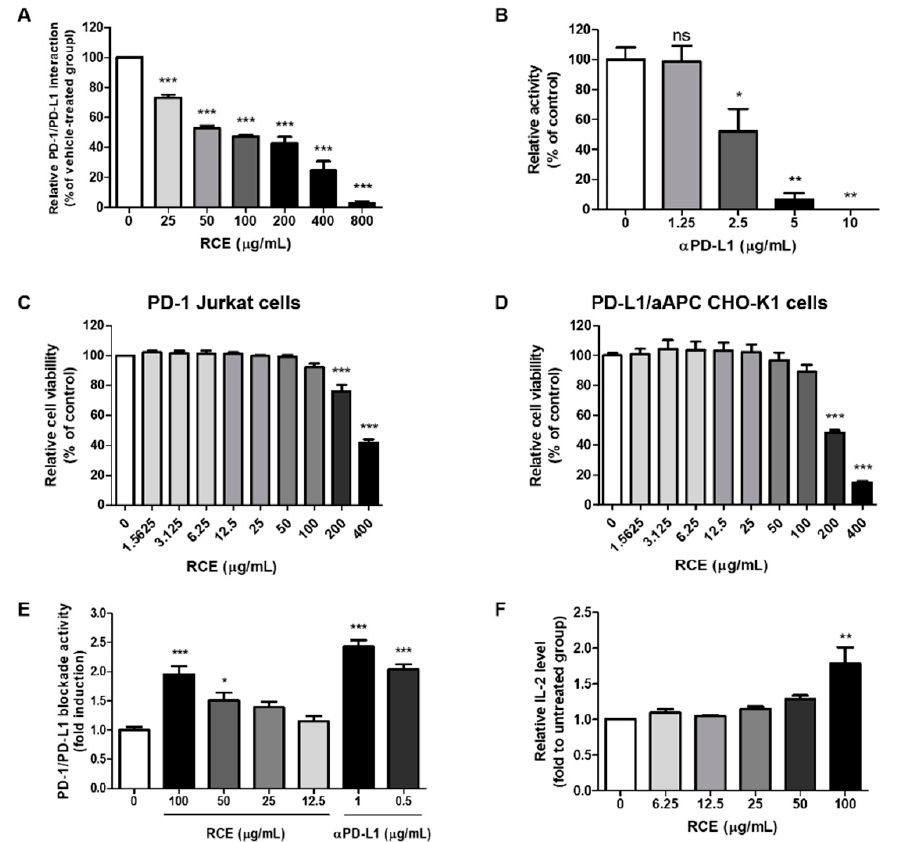
Figure 1. E ff ect of Rubus coreanus extract (RCE) on programmed cell death protein 1 (PD-1) / PD-1 ligand-1 (PD-L1) protein interaction using competitive enzyme-linked immunosorbent assay (ELISA) or cell-based assay. ( A , B ) The e ff ect of RCE on the binding of PD-1 and PD-L1 in vitro using a competitive ELISA assay. ( C , D ) The e ff ect of RCE on cell viability of PD-1 / NFAT Jurkat cells ( C ) and PD-L1 / aAPC CHO-K1 cells ( E ) using the Cell Counting Kit-8 (CCK) assay. Each of the cells were treated according to the indicated concentrations of RCE for 24 h. ( E ) The e ff ect of RCE on cellular PD-1 / PD-L1 blockade activity. PD-1 / NFAT Jurkat e ff ector cells and PD-L1 / aAPC CHO-K1 target cells were co-cultured with RCE or α PD-L1 for 24 h at the indicated concentrations. The relative PD-1 / PD-L1 blockade activity were measured by PD-1 / NFAT luciferase reporter assay. ( F ) E ff ect of RCE on IL-2 cytokine release in co-cultured cell model. Cell culture media was analyzed to measure IL-2 level by cytokine ELISA. Data are presented as mean ± S.E. of three representative independent experiments. Asterisks indicate significant inhibition of PD-1 / PD-L1 binding activity by each test inhibitor as compared with the vehicle-treated group; *** p < 0.001, ** p < 0.01, * p < 0.05, compared with the vehicle group.